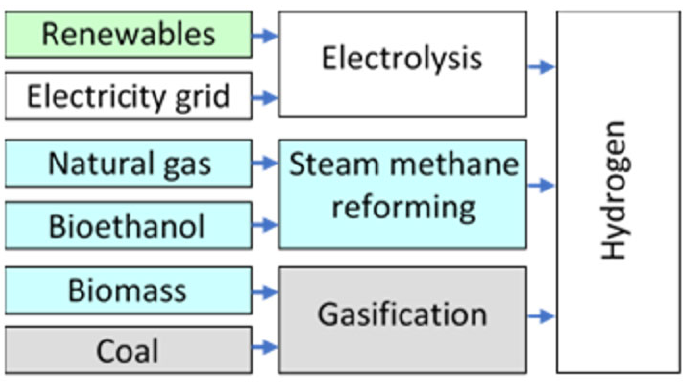
Figure 10. Methods for producing